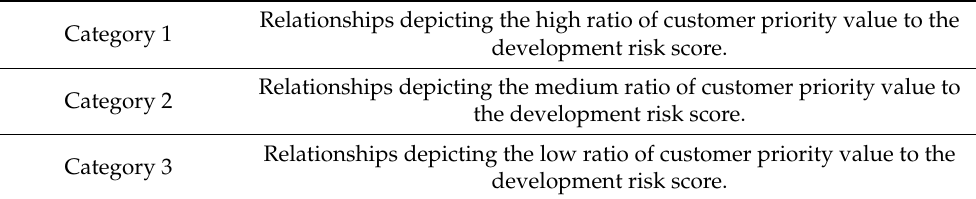
Table 1. Risk–value relationship categorization. Category